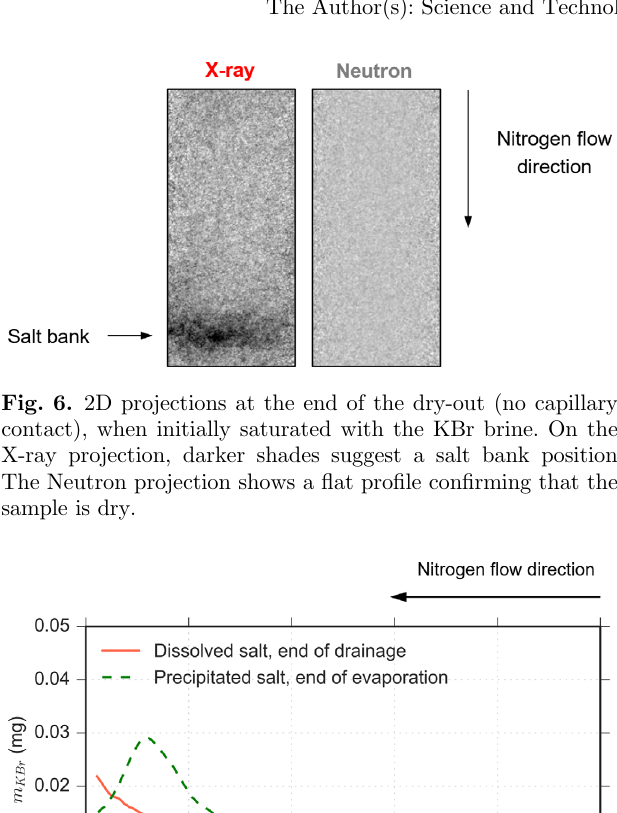
Fig. 8. Dry-out with the 100 g/L KBr brine and a capillary contact maintained at the gas outlet (high-pressure gradient case). The mass of salt is given for a pore volume of 0.31 cc.